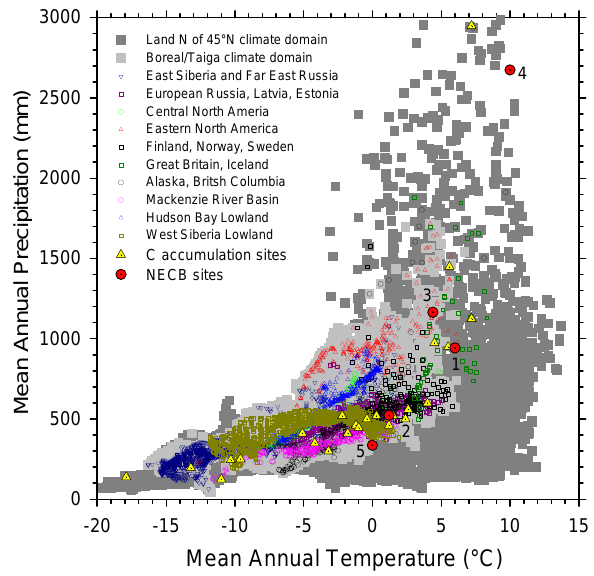
Fig. 2. Distribution of contemporary NECB sites in the climate space of mean annual temperature and precipitation of the north- ern peatland domain. The locations of NECB (net ecosystem car- bon balance) (red circles; n = 5) and Holocene carbon accumula- tion sites (yellow triangles; n = 33) are shown. NECB site numbers are the same as in Table 3: site 1: Mer Bleue; 2: Deger¨o; 3: Auchen- corth; 4: Glencar; and 5: Stordalen. The 33 carbon accumulation sites were used to derive the synthesis carbon accumulation curve in Fig. 1c (see Yu et al., 2009 for detail and site information). Mod- ified from Yu et al.